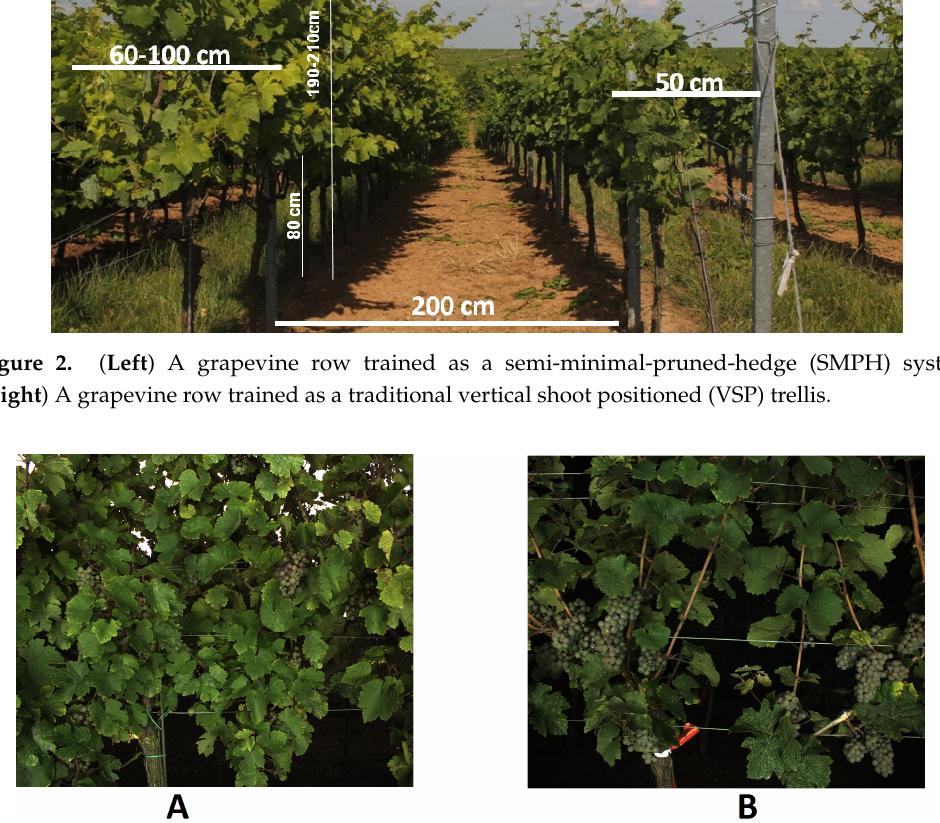
Figure 3. ( A ) A grapevine row trained as SMPH; ( B ) A grapevine row trained as a VSP